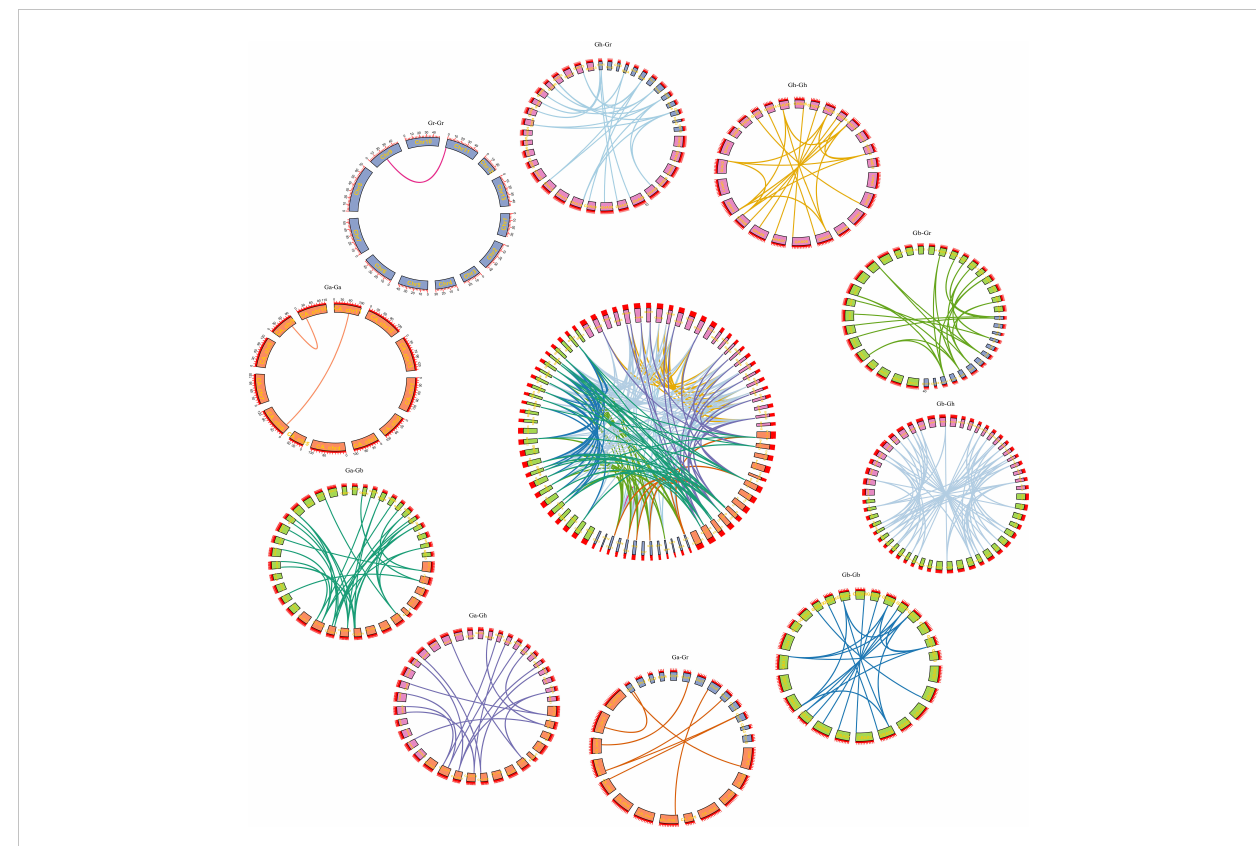
FIGURE 4 Syntenic relationship of SS duplicate gene pairs in